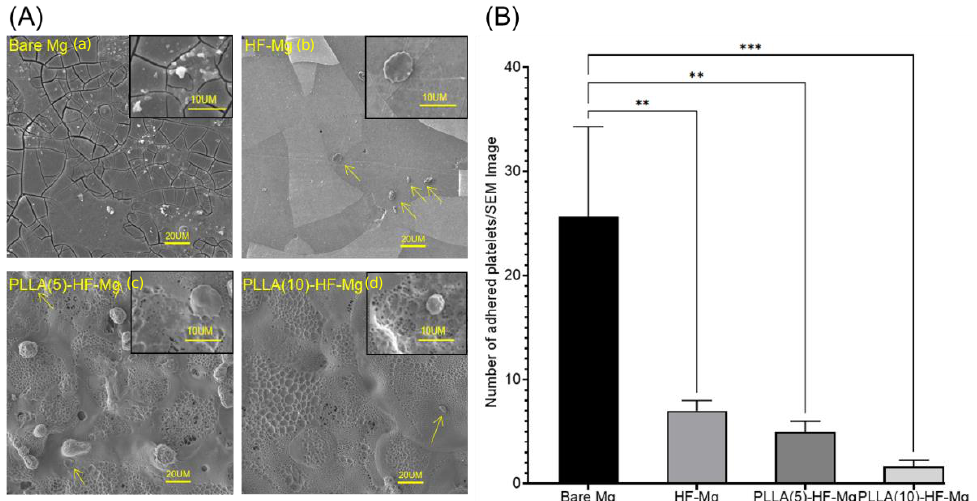
Figure 13. ( A ) Platelet adhesion tests of ( a ) bare Mg alloy ( b ) HF-Mg ( c ) PLLA (5)-HF-Mg ( d ) PLLA (10)-HF-Mg. ( B ) Number of adhered platelets/SEM Image, (** p < 0.01, *** p < 0.001).